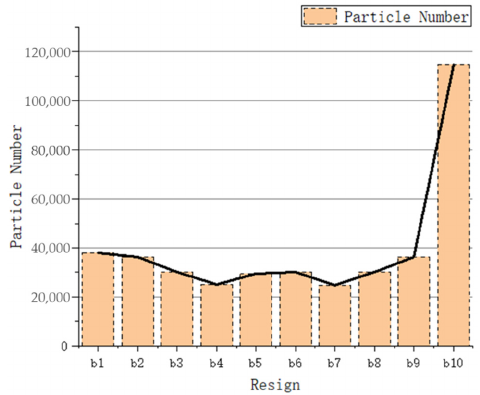
Figure 18. Number of particles in b1~b10. Energies 2022 , 15 , 6096